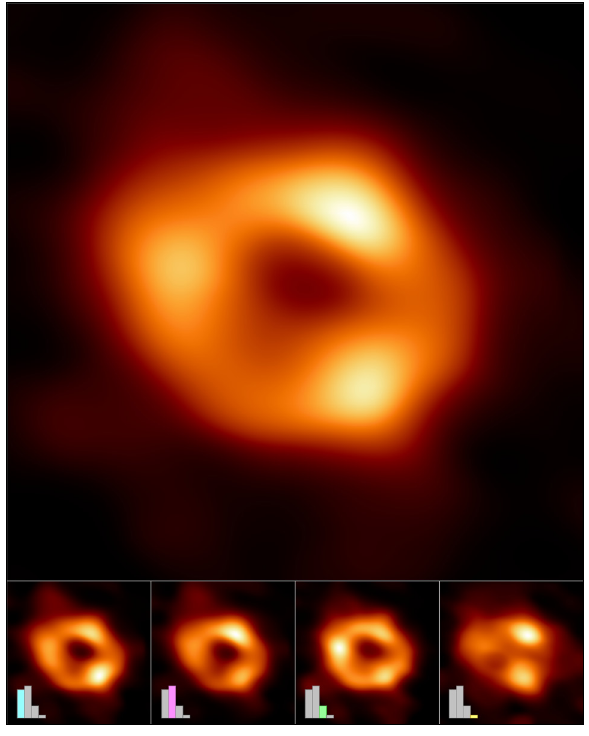
Source: Reproduced from Figure 3 of EHT Collaboration et al. 4 Figure 2: Image of the supermassive black hole Sagittarius A* located at the centre of our galaxy. The main image (top) was produced by averaging together thousands of images created using different computational methods — all of which accurately fit the EHT data. The images are clustered into four groups based on similarity of features (bottom). The bar graphs show the relative number of images belonging to each cluster, with their heights indicating the relative contribution of each cluster to the main